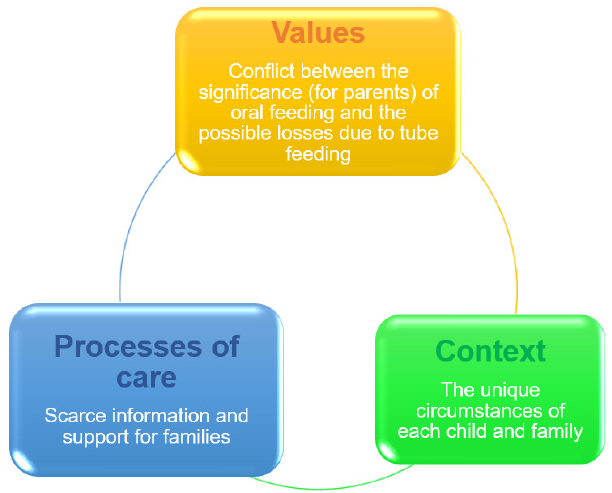
Figure 1. Decisional conflict over tube feeding [44,46].